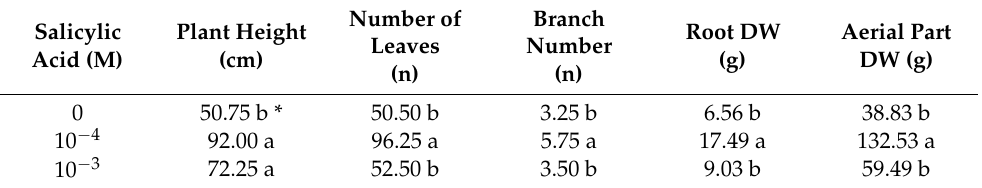
Table 2. Effect of different concentrations of salicylic acid on plant height (cm), number of leaves (n), branch number (n), DW of root and aerial parts (g) of S. marianum L.